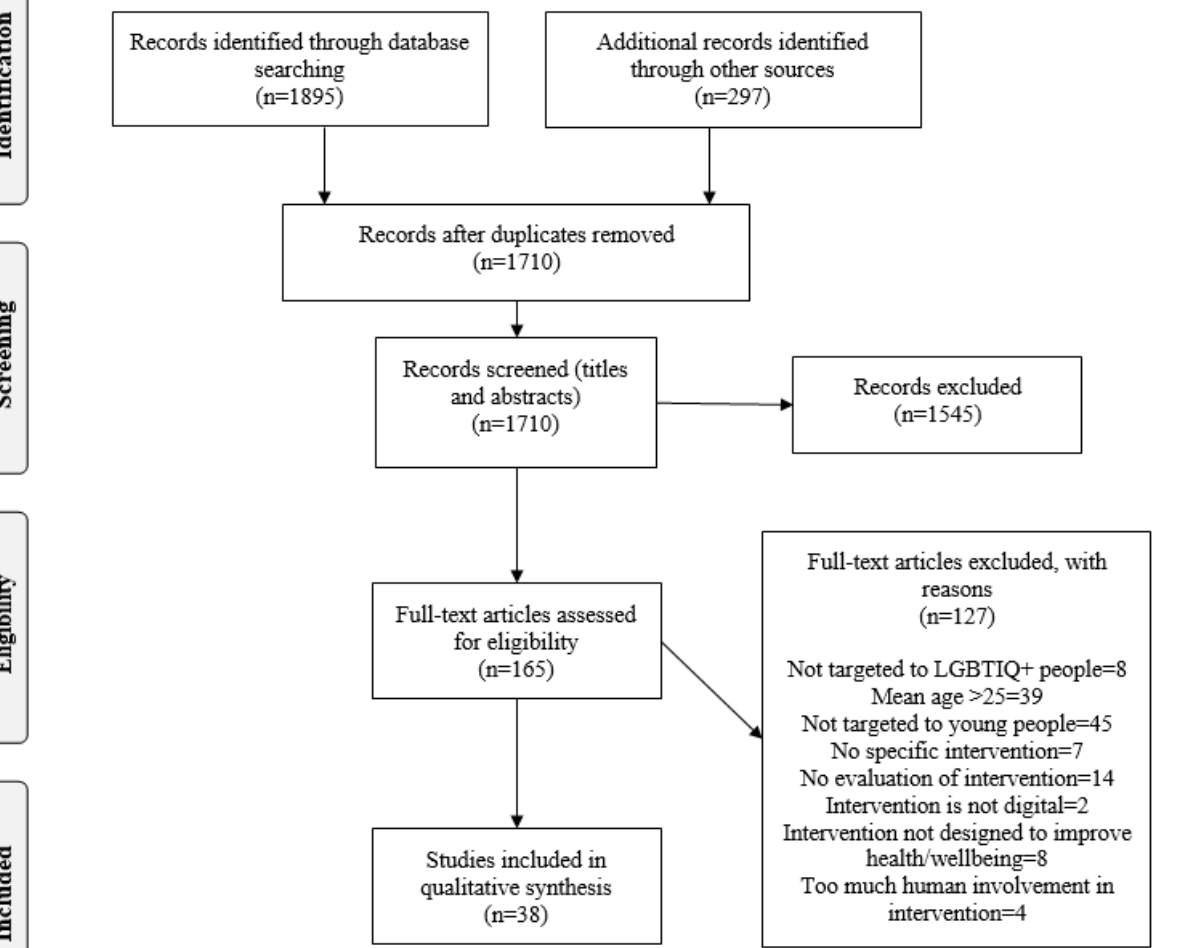
Figure 1. Study flowchart. LGBTIQ+: lesbian, gay, bisexual, transgender, intersex,